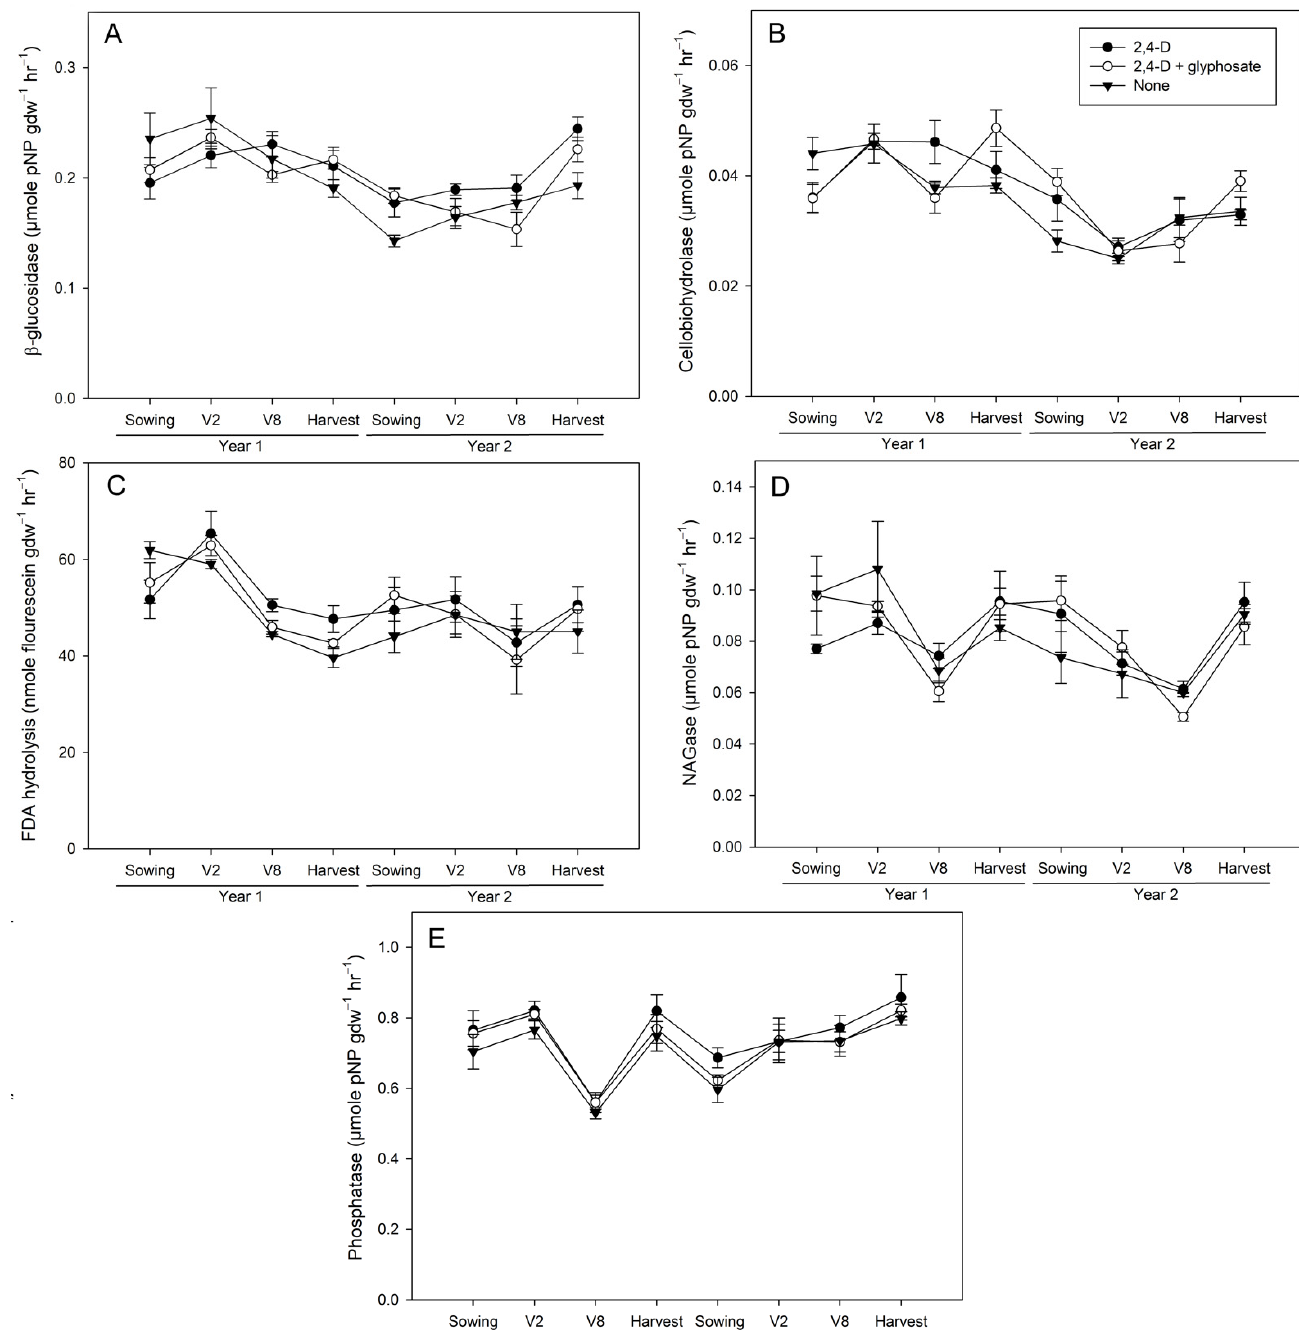
Figure 3. Activity of beta-glucosidase ( A ), cellobiohydrolase ( B ), fluorescein diacetate (FDA) hydroly- sis ( C ), N-acetylglucosaminidase (NAGase) ( D ), and phosphatase ( E ) in 5–15 cm soil from 2,4-D-only (closed circle), 2,4-D+glyphosate (open circle), and untreated control (closed triangle) plots for each timepoint during the two-year study. Values represent mean ± standard error (n = 4).